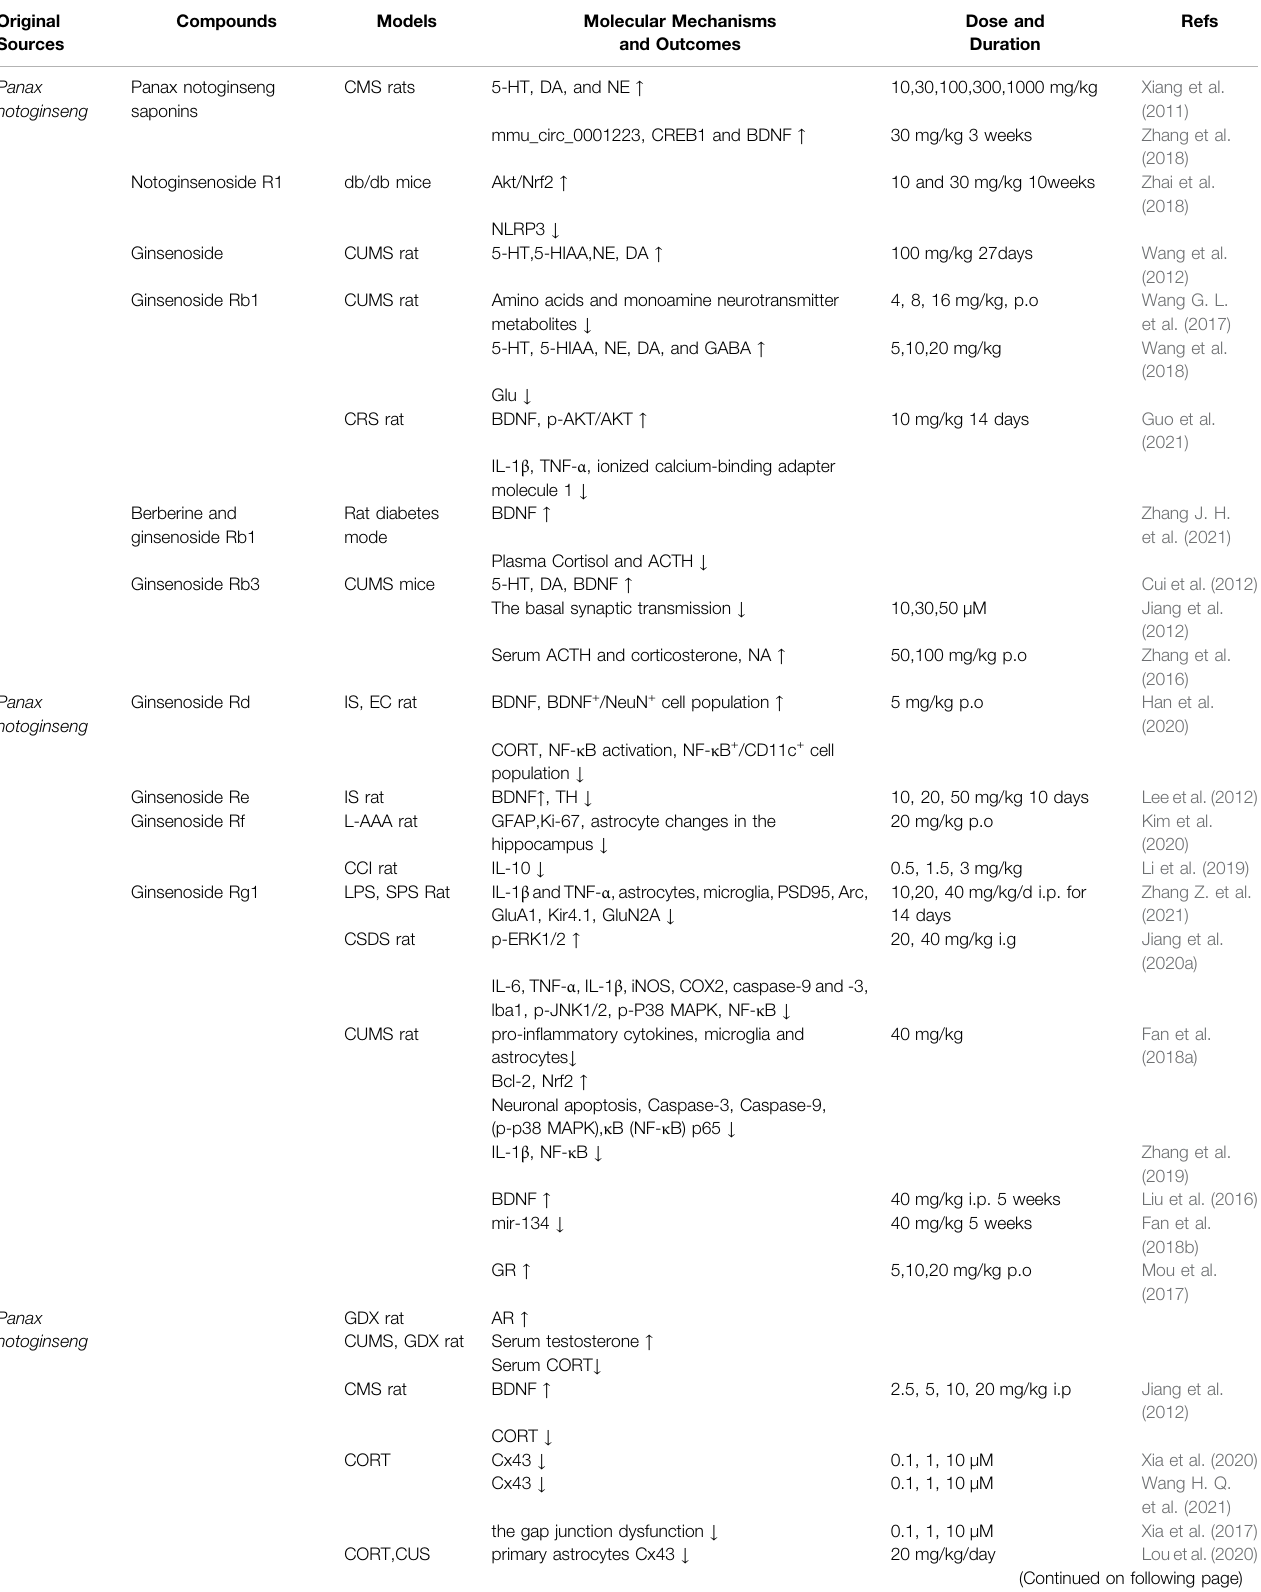
TABLE 1 | The illustration of molecular mechanisms and outcomes of activated Panax notoginseng